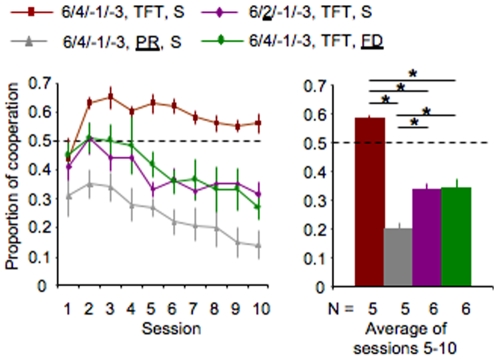
Cooperation levels vary with the different iPD games.Left panel shows time-course of cooperation rate along the ten game sessions for each iPD game (mean±s.e.m.). Each line represents one of the games tested. Right panel shows proportion of cooperation in each iPD game (mean±s.e.m.) when cooperation reaches stability (see methods). Each bar represents one game (same colour as in line graph). Asterisk, denote significant difference between means (Multiple pairwise comparisons, using Dunn's Procedure, two tailed Bonferroni corrected, P<0.0083).